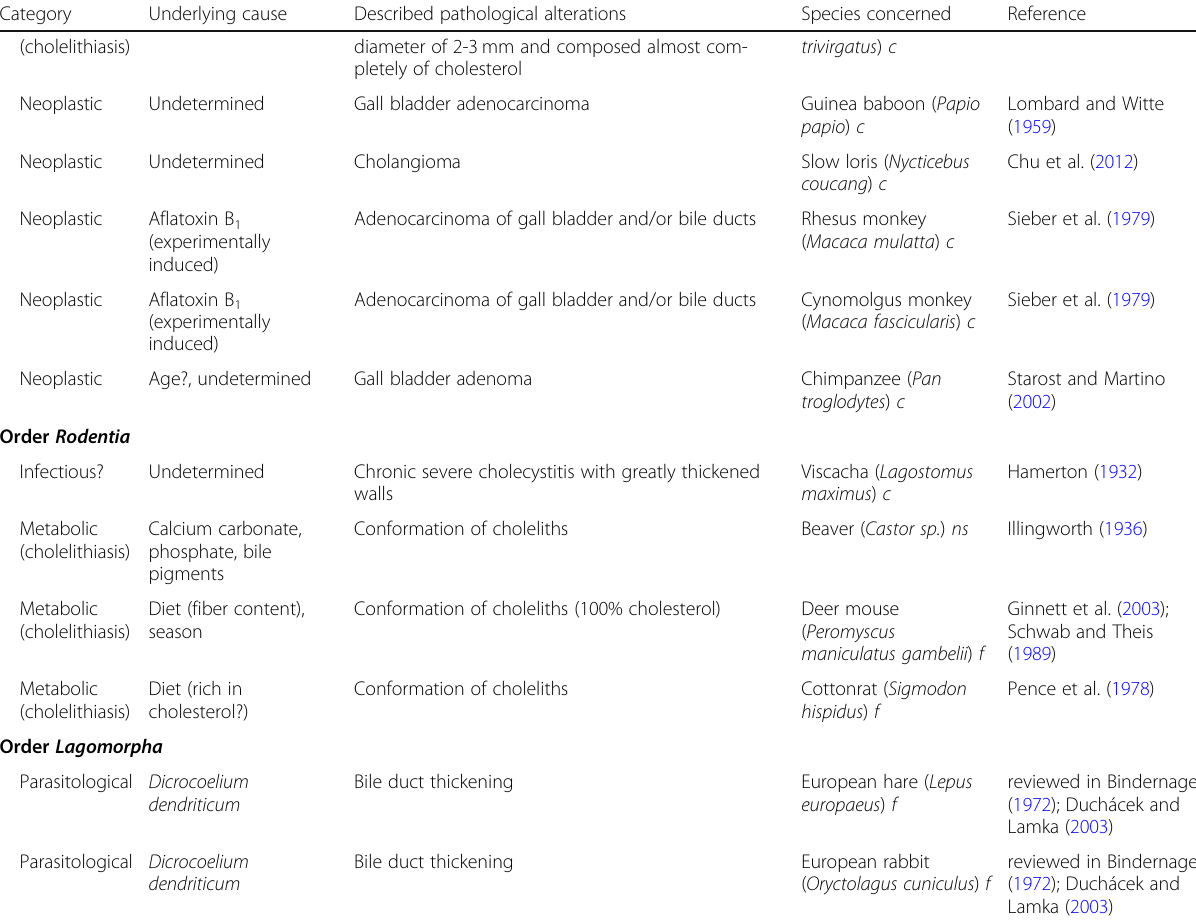
Table 1 Reported pathologies of the extrahepatic biliary tract in mammalian exotic pets and wildlife species (Continued)